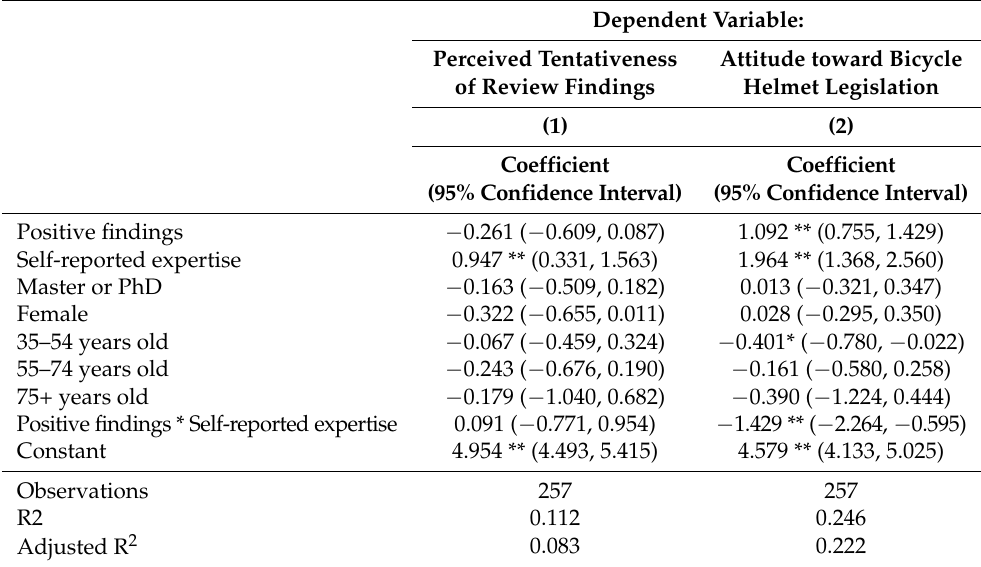
Table 4. OLS regression results for the third set of research hypotheses involving self-reported expertise in helmet